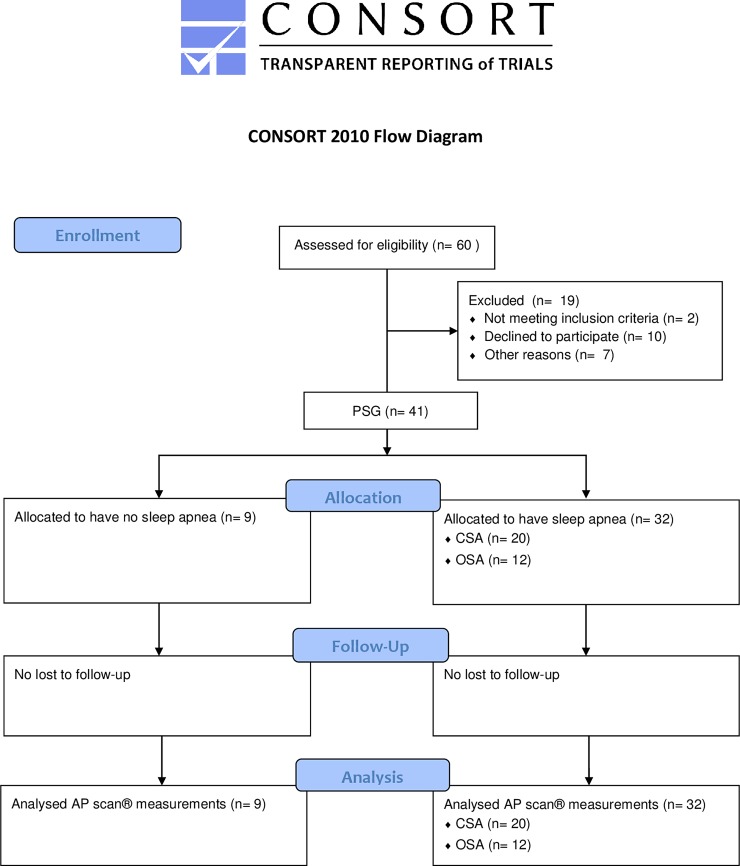
CONSORT diagram of the UPGRADE study.